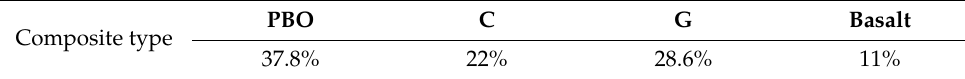
Table 15. The percentage of composite type in strengthened column.